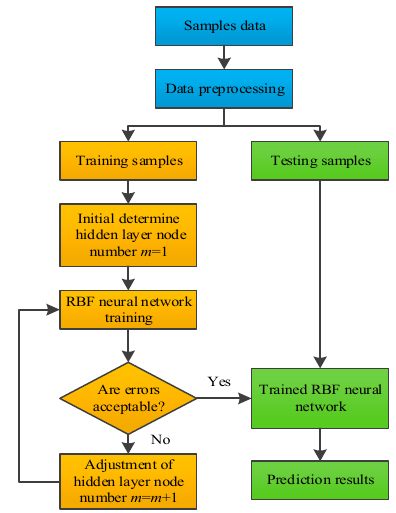
Figure 7. Implementing process of the RBF neural network for modeling and prediction.